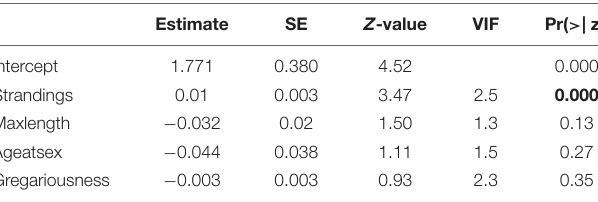
TABLE 3 | Summary of model-averaged coefficients from negative binomial GLM to model the relationships of research effort (response variable) of Philippine marine mammal species and their life history parameters and data sources (predictor